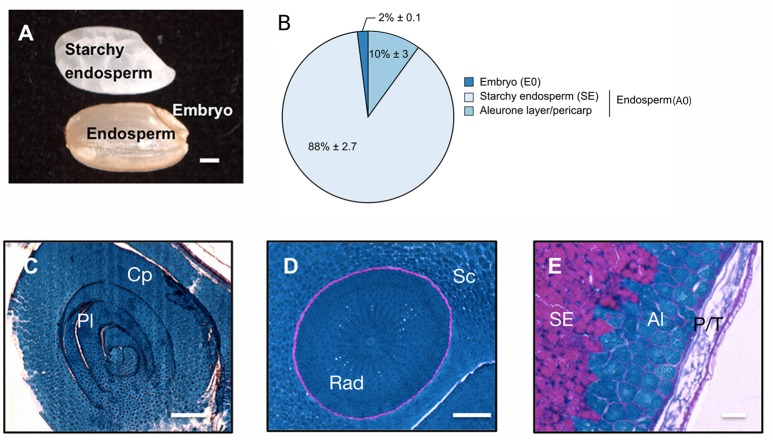
Description of the dry mature rice seed. (A) The dry mature rice seed (Oryza sativa ssp. japonica cv Nipponbare) is composed of several tissues including the embryo, endosperm (pericarp, testa, aleurone layer and starchy endosperm) and inner starchy endosperm. Scale bar, 1 mm. (B) Dry weight per seed of the isolated embryo (E0), starchy endosperm and the aleurone layer/pericarp tissue. The average percentage of each seed tissue is indicated (average % per seed) along with its standard-deviation (n = 10). The endosperm (A0) is the combination of the starchy endosperm (SE) and of the aleurone layer/pericarp tissue. (C–E) Proteins (blue) and complex carbohydrates (including starch, pink) were revealed using a Periodic Acid Schiff—Naphthol Blue Black staining on 5 μm historesin-embedded semi-thick sections. Stained sections of the embryo shoot apical meristem (C, longitudinal cut), embryo radicule (D, transversal cut) and endosperm dorsal side (E) were visualized by optic microscopy. Scale bars represent 100 μm in (C,D) and 25 μm in (E). Al, Aleurone layer; Cp, coleoptile; Pl, plumule; P/T, pericarp/testa; Rad, radicle; Sc, scutellum; SE, starchy endosperm.